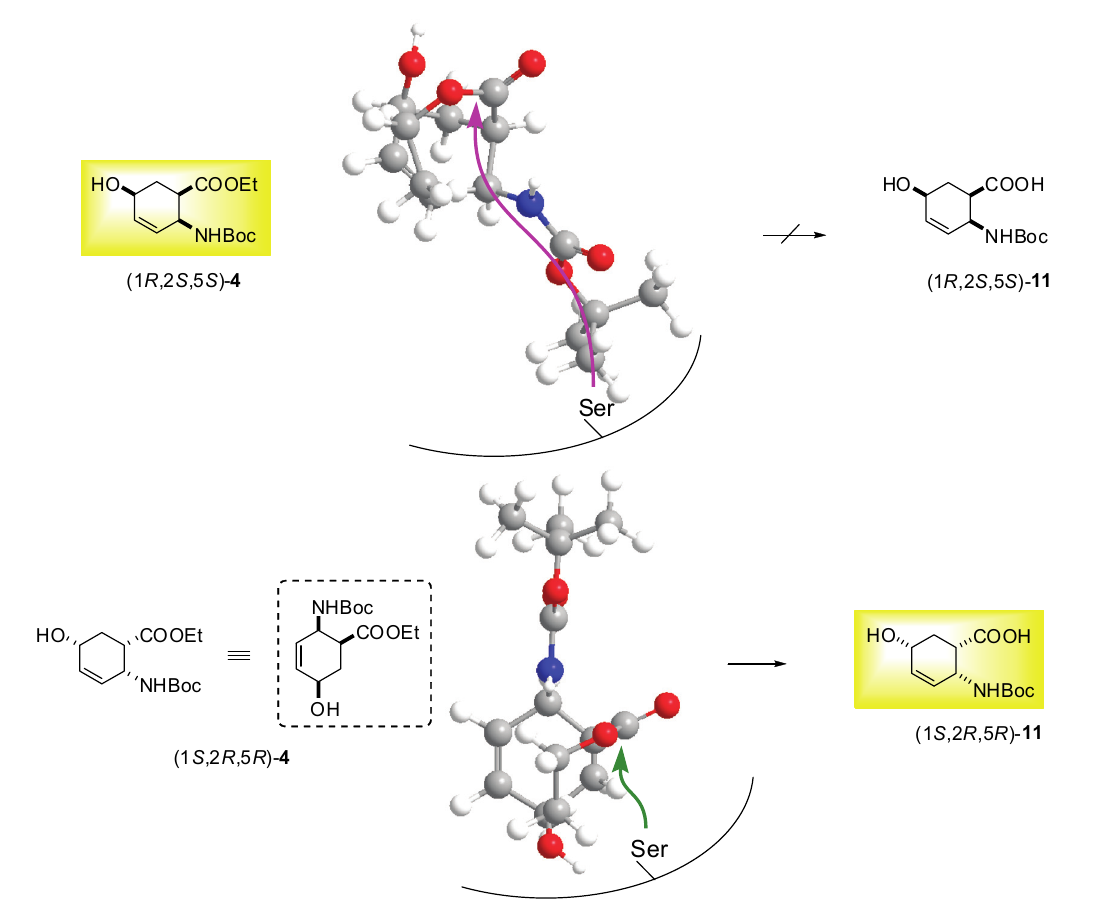
Figure 2. S -selective hydrolysis of (1 S *,2 R *,5 R *)-( ± )- 4 .